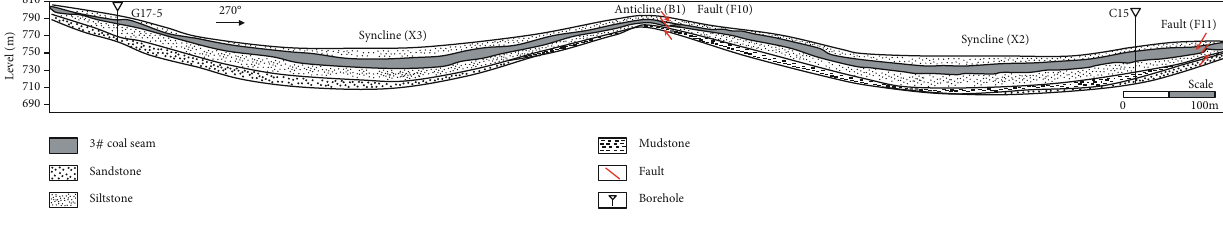
Figure 3: Geological section of the 1302 coal mining face.